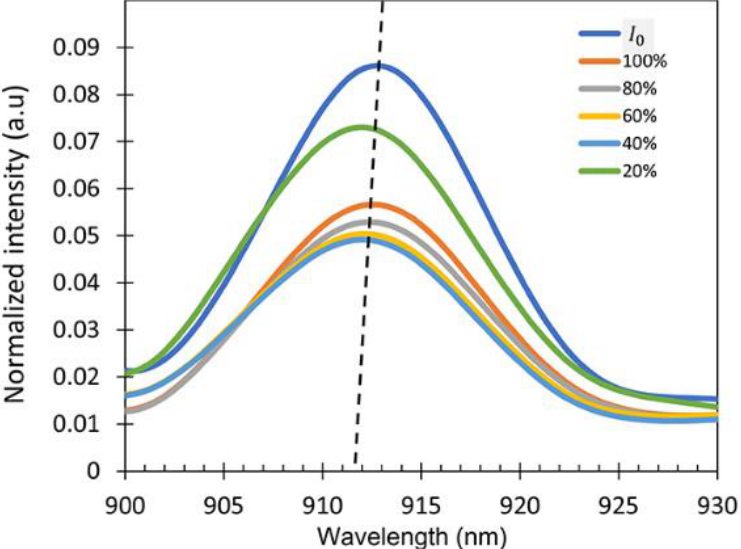
Figure 8. Intensity spectra at different IPA concentrations showing peak wavelength at around λ = λ = 900–930 nm (dotted lines showing the shift as a guide to the 900 – 930 nm (dotted lines showing the shift as a guide to the eye).